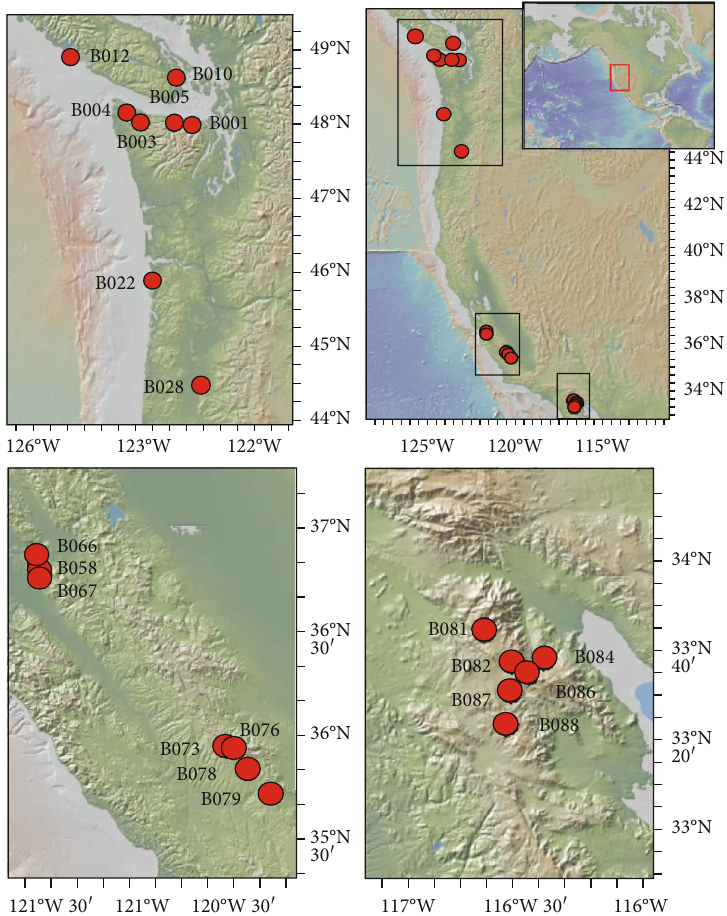
Figure 1: Map of study area with boreholes indicated by red dot boreholes clustered into northern, central, and southern